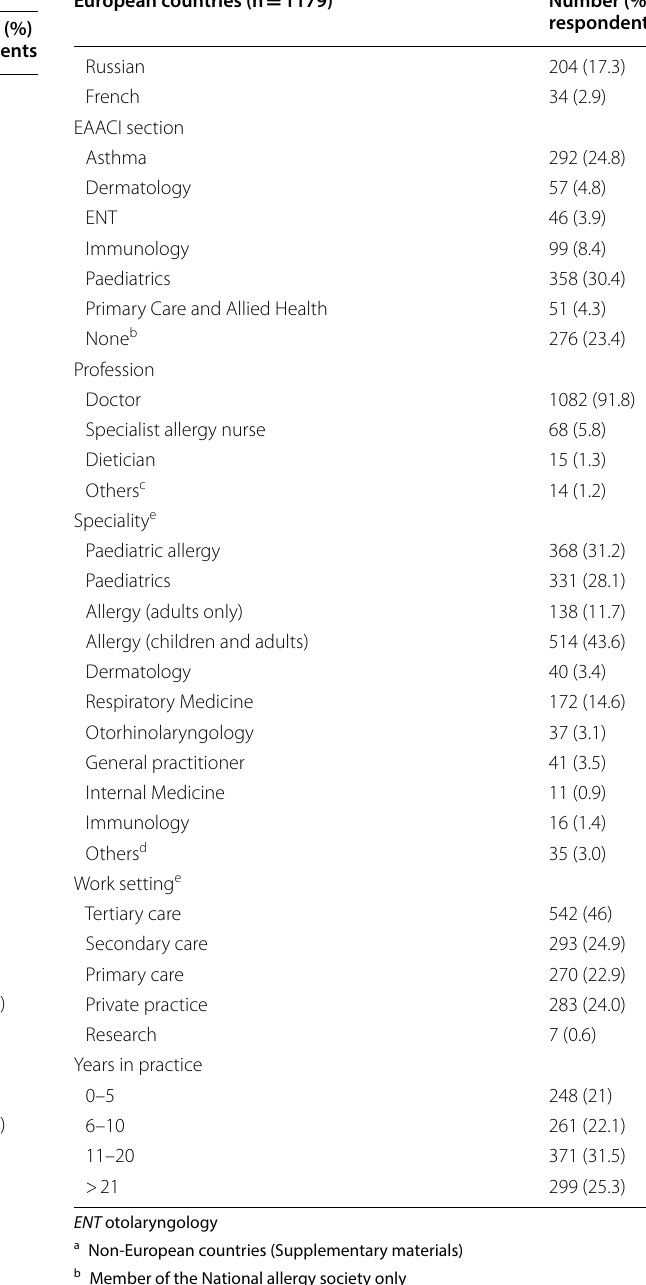
Table 1 Demographics of survey responders and practice